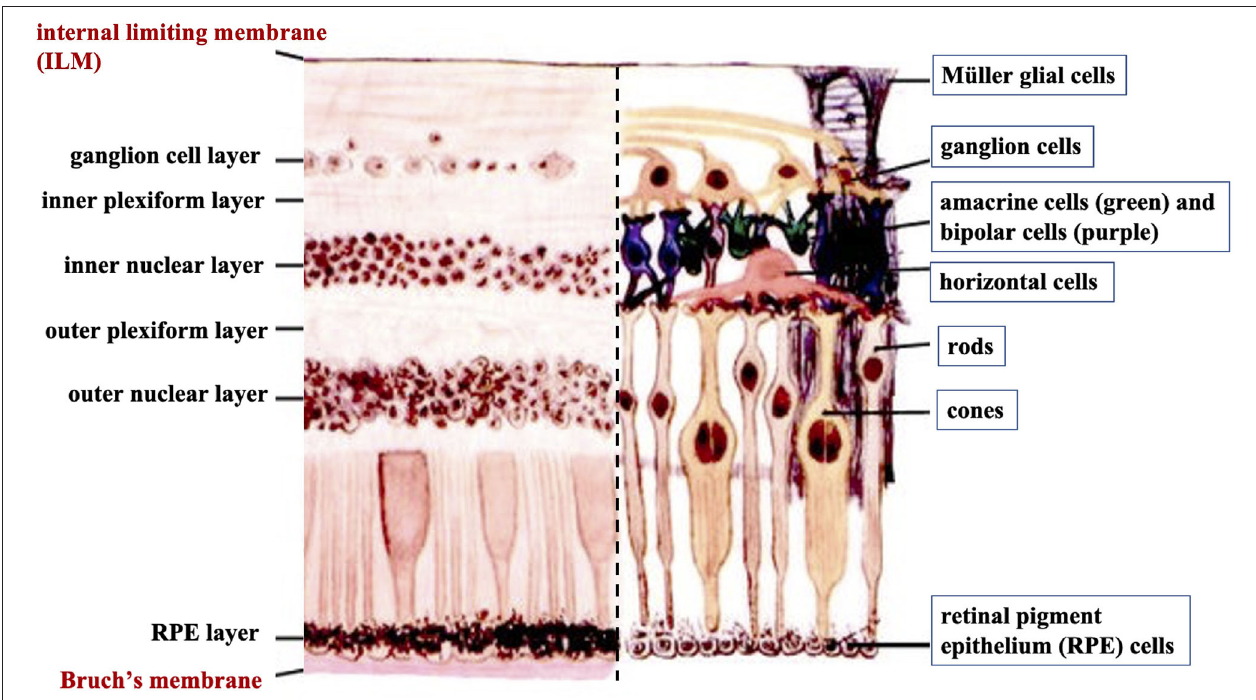
FIGURE 3 | A cross-sectional histological image of the retina, with its different layers (left) and the corresponding diagrammatic image depicting the different cell types of the retinal neural layers